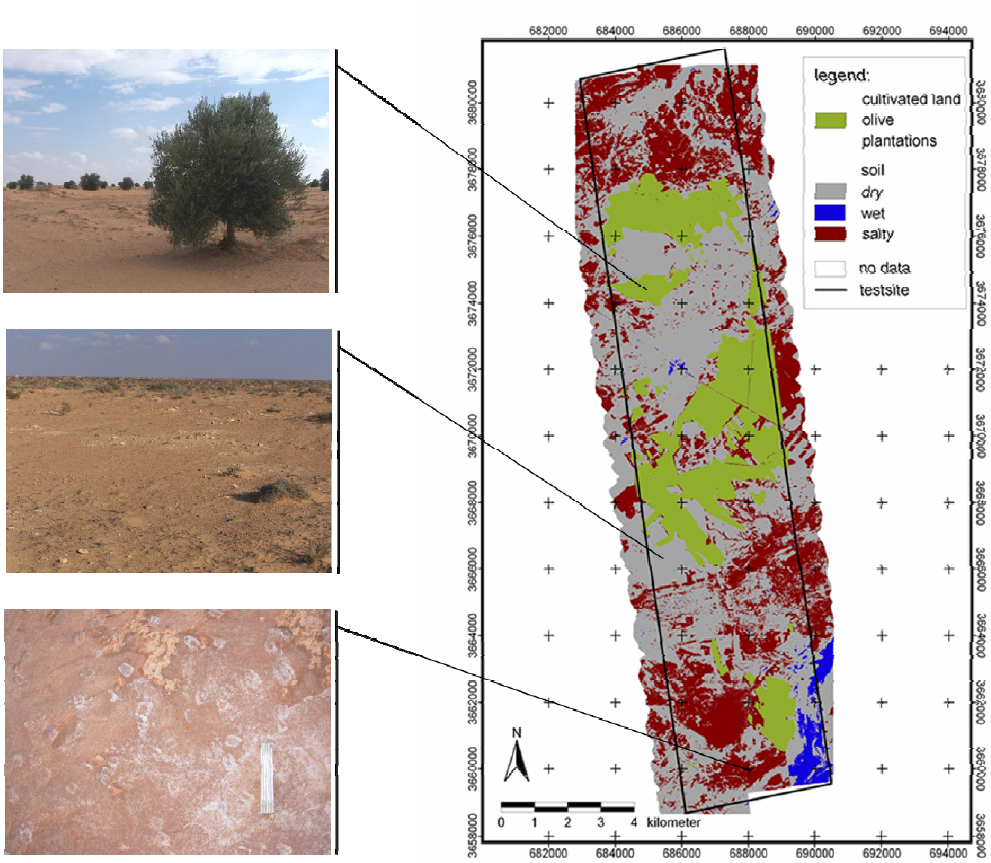
Figure 16. Land use map of Ben Gardane on the basis of AVIS-2 and E-SAR data provided by VISTA [27]. The photographs were conducted during the ground measurement campaign and show olive plantations (top), a pastoral area (center), and salt crust formation near a well (bottom)